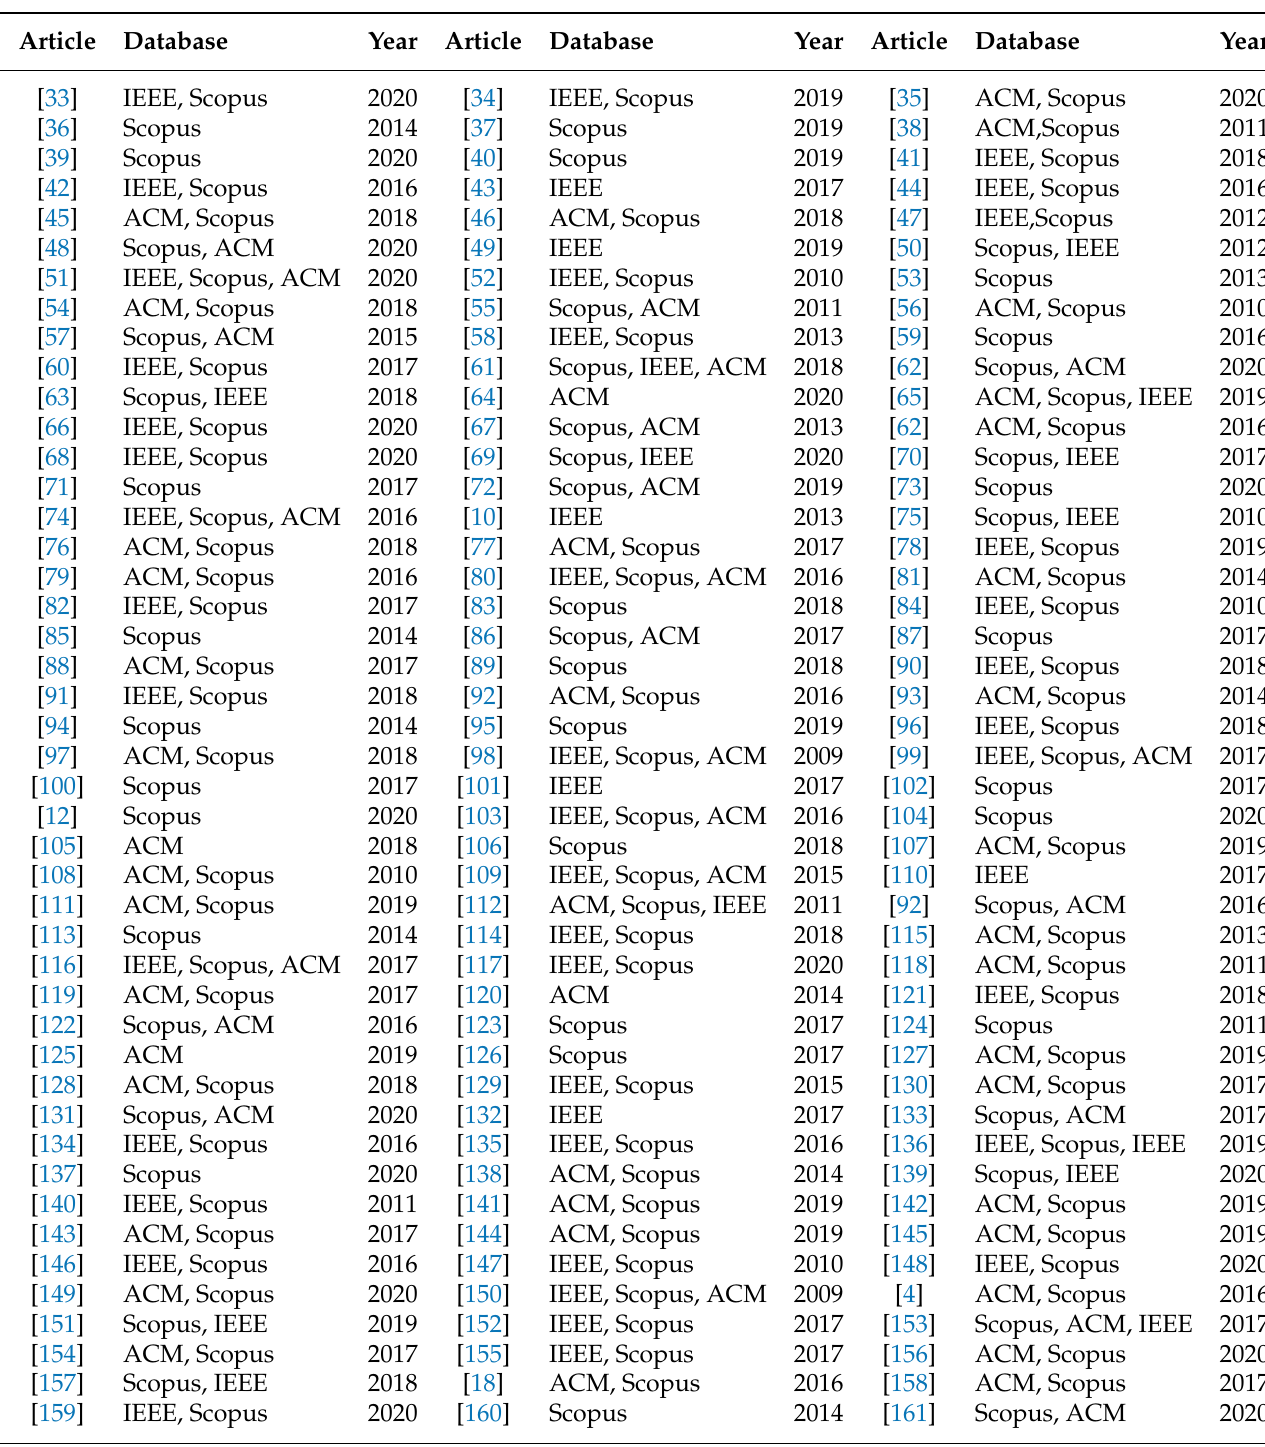
Table 4. Articles that contain the search keywords in their